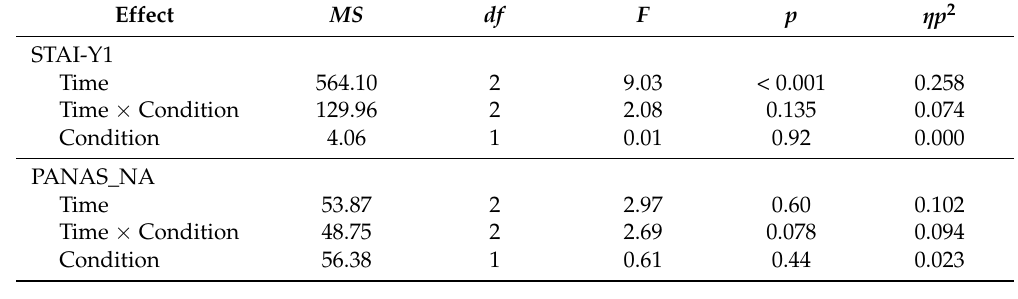
Table 3. Results of main effects of repeated measures ANOVAs for the comparative effect of cognitive exposure generalized anxiety disorder (GAD) scenarios presented in imagination and in virtual reality.